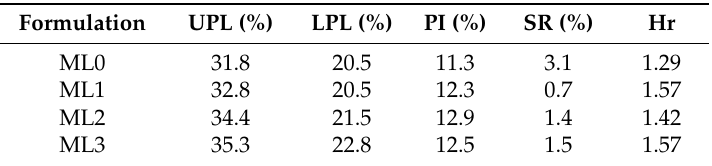
Table 5. Physical parameters of the floor tile formulations.